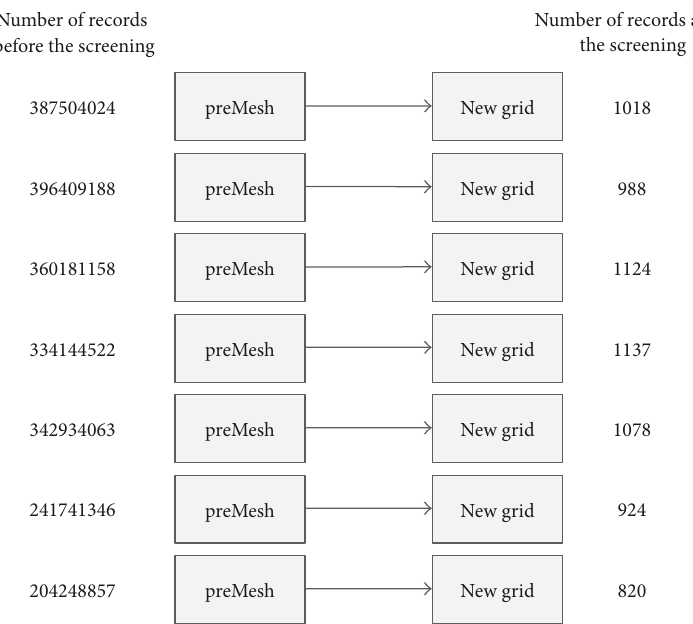
Figure 7: Decrease in the number of records after the screening of unreliable vehicles.